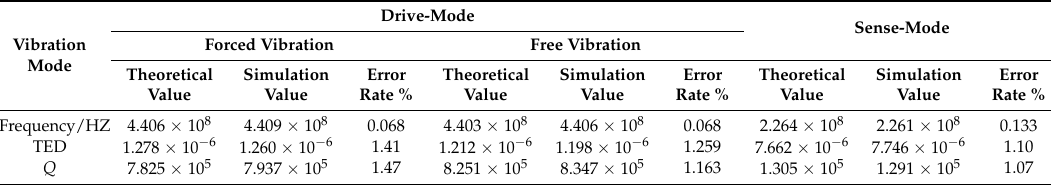
Figure 14. Quality factor under different conditions. Table 3. TED and Q simulation and analytical results for vibration at drive-mode and sense-mode.